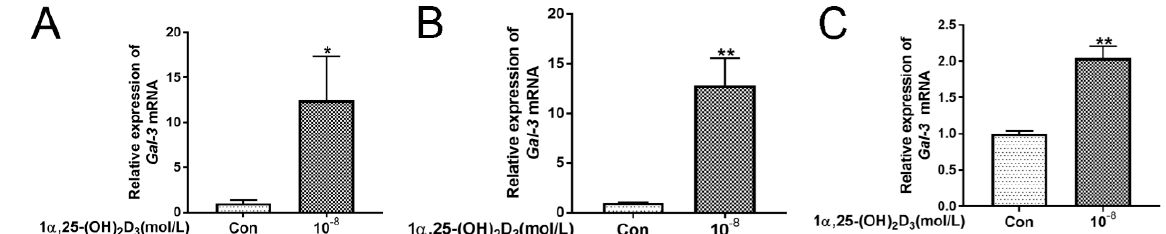
Figure 2. Application of 10 − 8 mol/L 1 α ,25(OH) 2 D 3 upregulates the expression of Gal-3 mRNA in the BMSC–BMM co-culture system and monocultures. ( A ) BMSCs and BMMs were co-cultured in 6-well plates with or without (Con) 1 α ,25(OH) 2 D 3 . Quantitative RT-PCR was used to quantitate the expression of Gal-3 mRNA. ( B ) BMSCs were seeded in 6-well plates with or without (Con) 1 α ,25(OH) 2 D 3 , and qRT-PCR was used to quantitate the expression of Gal-3 mRNA. ( C ) BMMs were seeded in 6-well plates with or without (Con) 1 α ,25(OH) 2 D 3 , and qRT-PCR was used to quantitate the expression of Gal-3 mRNA. (Graph bars show mean ± SD. * p < 0.05 and ** p < 0.01 show significant difference compared with the control group; n = 3 per group).